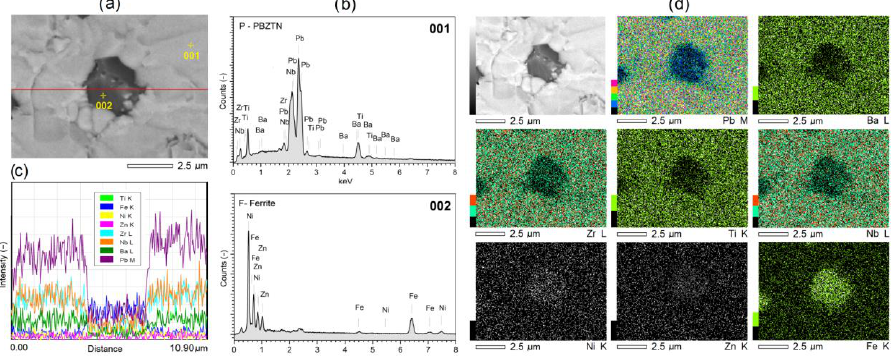
Figure 5. SEM/BSE microstructure image ( a ) subjected to ( b ) point and ( c ) linear EDS analysis and ( d ) EPMA maps of the distribution of individual elements in the PF-HP composite sample.